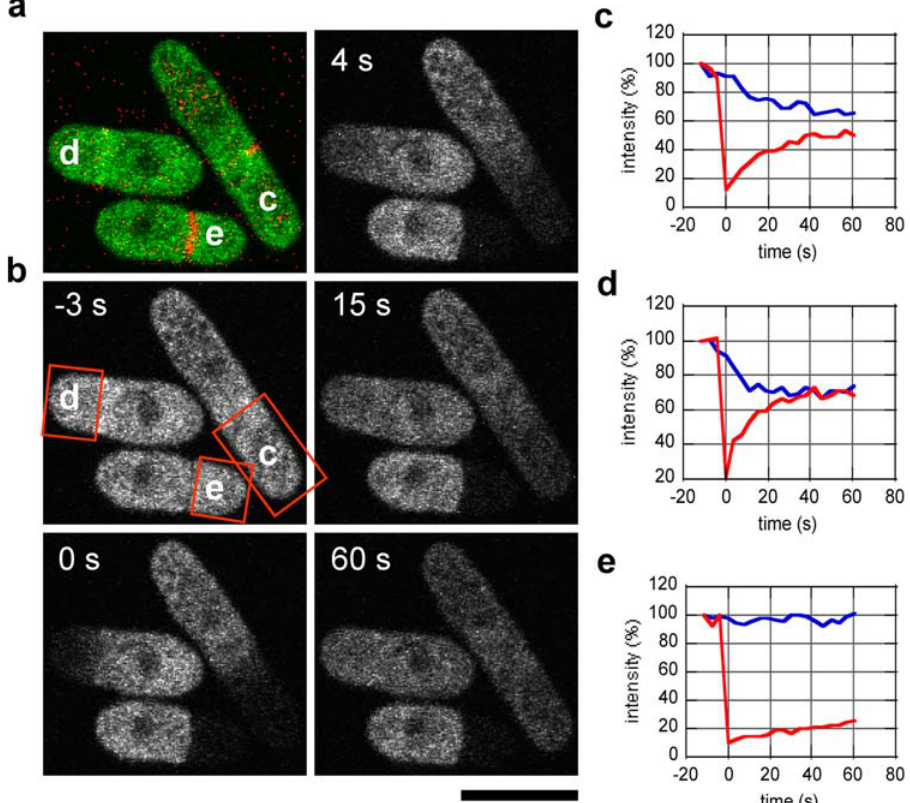
Figure 2. FRAP reveals distinct anucleate cells in thecdc16-116 mutant. (a) Merged pseudo-colors image of cdc16 -116 cells expressing Rad24p-GFP (green) stained with the cell wall tracer aniline blue (red). Temperature sensitive cdc16 -116 cells were treated with hydroxyurea (HU) for 6 h to arrest cells at S phase, and shifted to the non-permissive temperature of 36 u C for 2 h. The three cells shown are in different stages of septation, ranging from early septation (cell c) and mid-septation (cell d) with shared cytoplasm between the two daughter cell halves, to completed septation with a distinct cell wall separating the two daughter cell halves (cell e). (b) Fluorescence recovery after photobleaching (FRAP) was performed on cells at various stages of septation. Cell regions c, d, and e are regions that were photobleached (red dotted boxes). Shown is a time-lapse montage of the behavior of Rad24p-GFP within 60 s after photobleaching. (c, d, e) Normalized fluorescence recovery curves of cell c, d, and e, respectively. Cell c and d showed complete recovery within , 60 s after photobleaching ( % 1/2 , 8 s). The unbleached cell halves (blue lines) showed fluorescence decay as a mirror image to the fluorescent recovery of the bleached cell halves (red lines). Cell e showed no significant recovery in the bleached half, and no decay in the unbleached half. Scale, 5 m